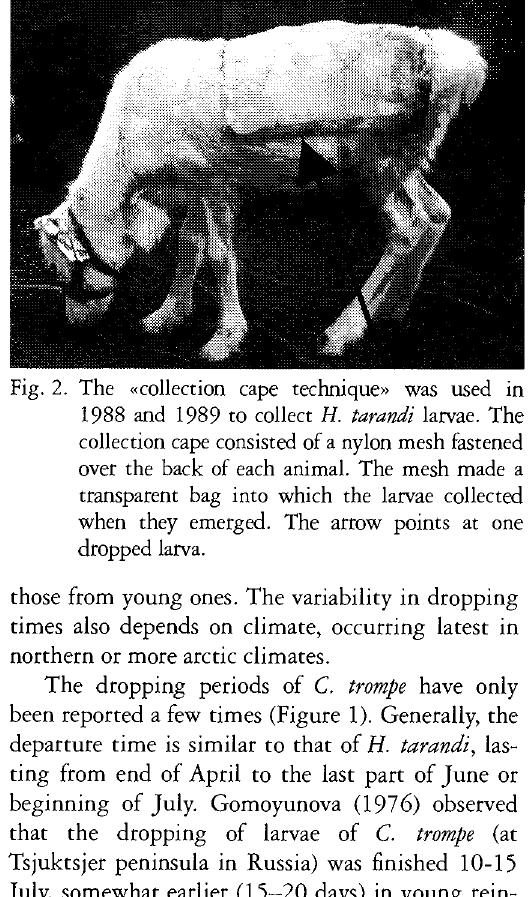
northern or more arctic